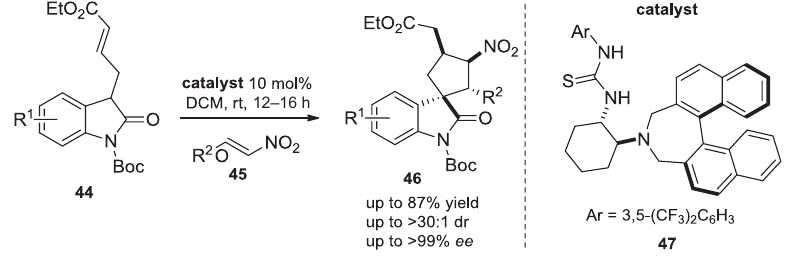
Figure 13. Thiourea catalyzed enantioselective synthesis, from Ref. ( I , Figure 15a). In the activation of a compound, e.g. carbonylic